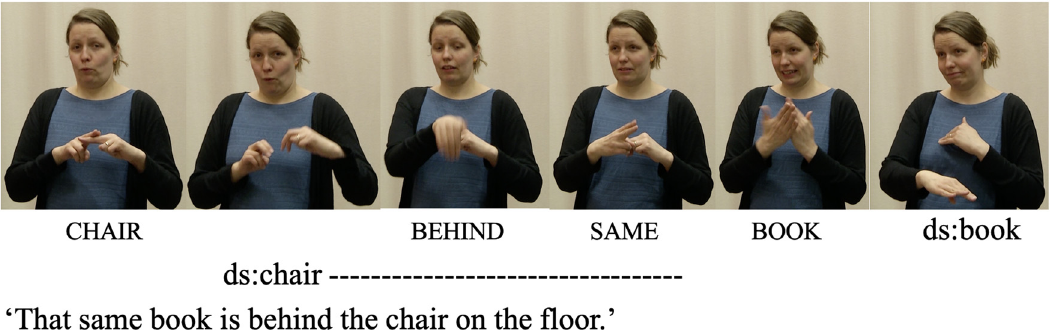
Figure 10: An example of the simultaneous production of Ground and adposition sign to locate a known Figure.